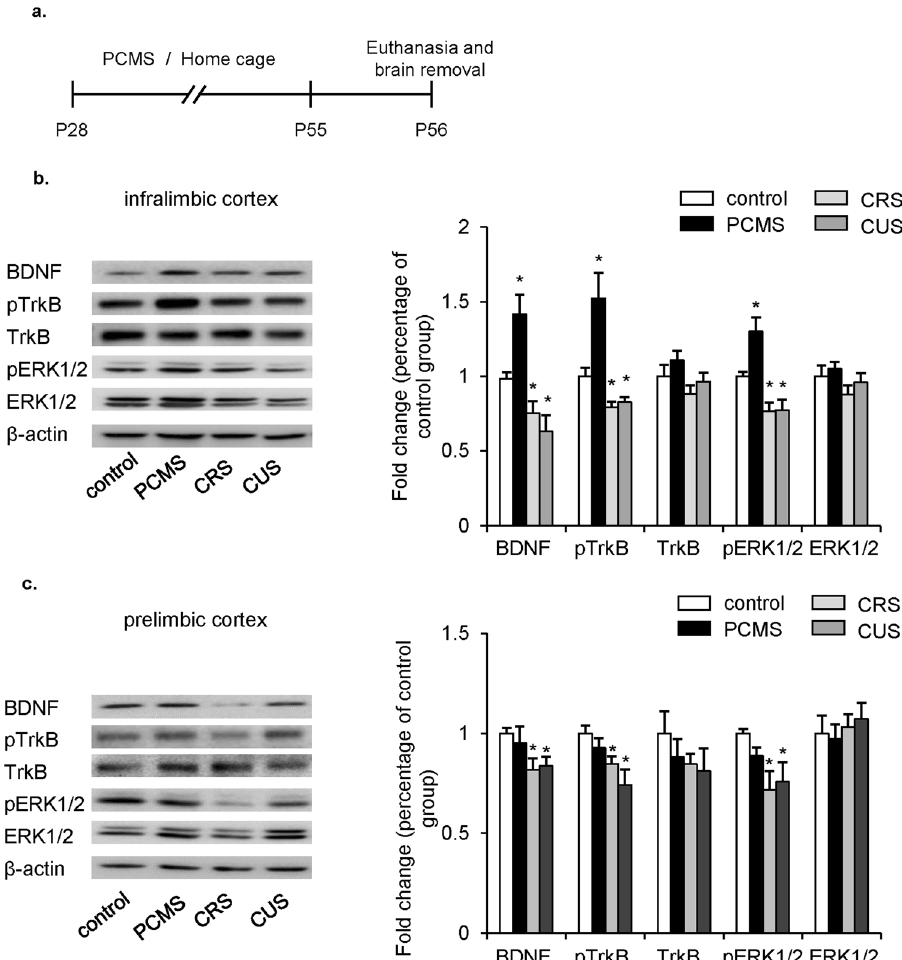
Figure 2. PCMS during adolescence elevated BDNF-ERK1/2 signaling activity in the IL in adulthood. ( a ) Experimental timeline. ( b , c ) Protein levels and representative western blot bands of BDNF, pTrkB, TrkB, pERK1/2, and ERK1/2 in the IL ( b ) and PrL ( c ) in different stress manipulated and control rats. Blots shown are cropped from full-length. The data are expressed as the mean ± SEM ( n = 6 per group). * p < 0.05, compared with the control